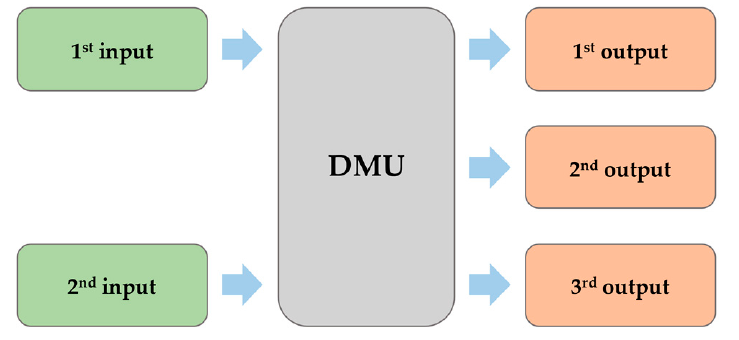
Figure 4. Two inputs and three outputs of the suggested model.